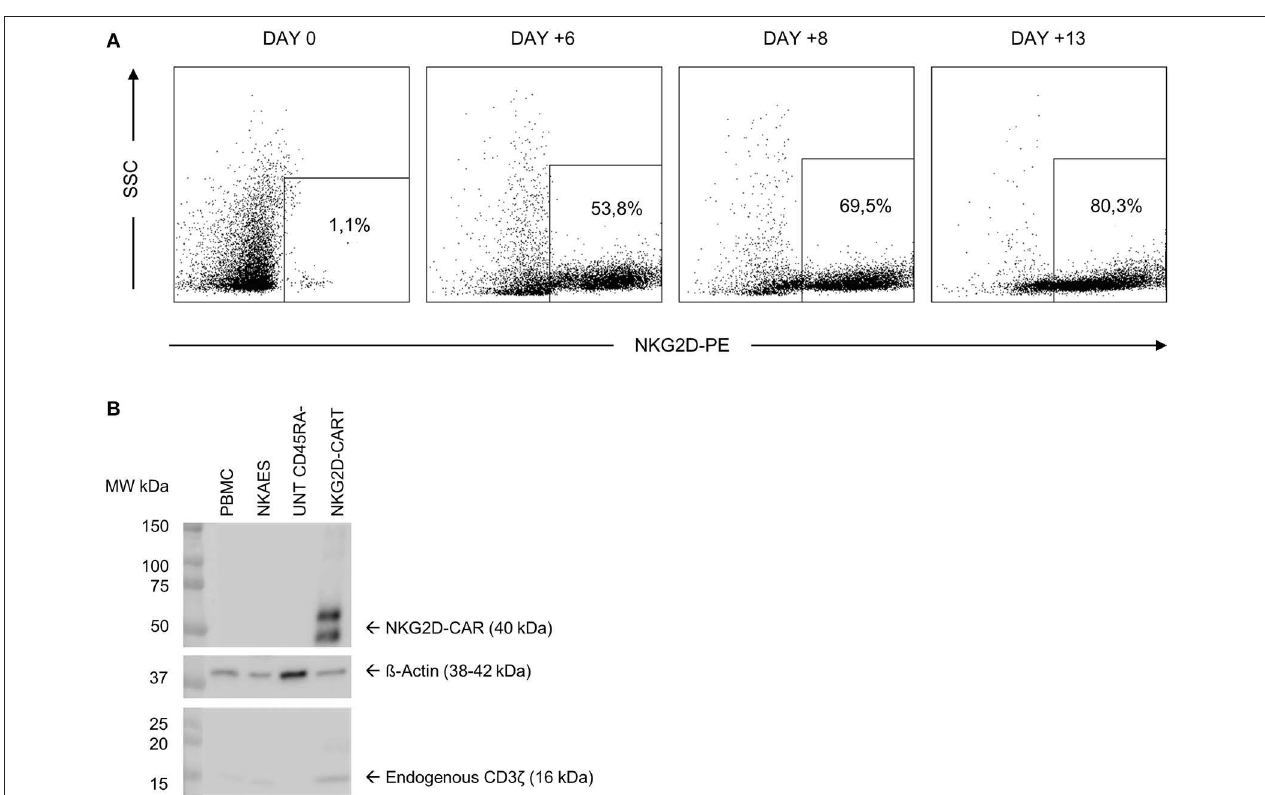
FIGURE 2 | NKG2D CAR expression in CD45RA − cells after transduction. (A) Representative FCM data showing an increase in NKG2D CAR expression along the manufacturing process. (B) Analysis of NKG2D CAR expression in transduced cells by western blot detecting CD3 ζ . NKG2D, natural killer group 2D; CAR, chimeric antigen receptor; FCM, flow